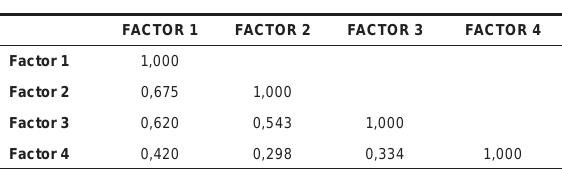
TAbLE 9 Factor intercorrelations